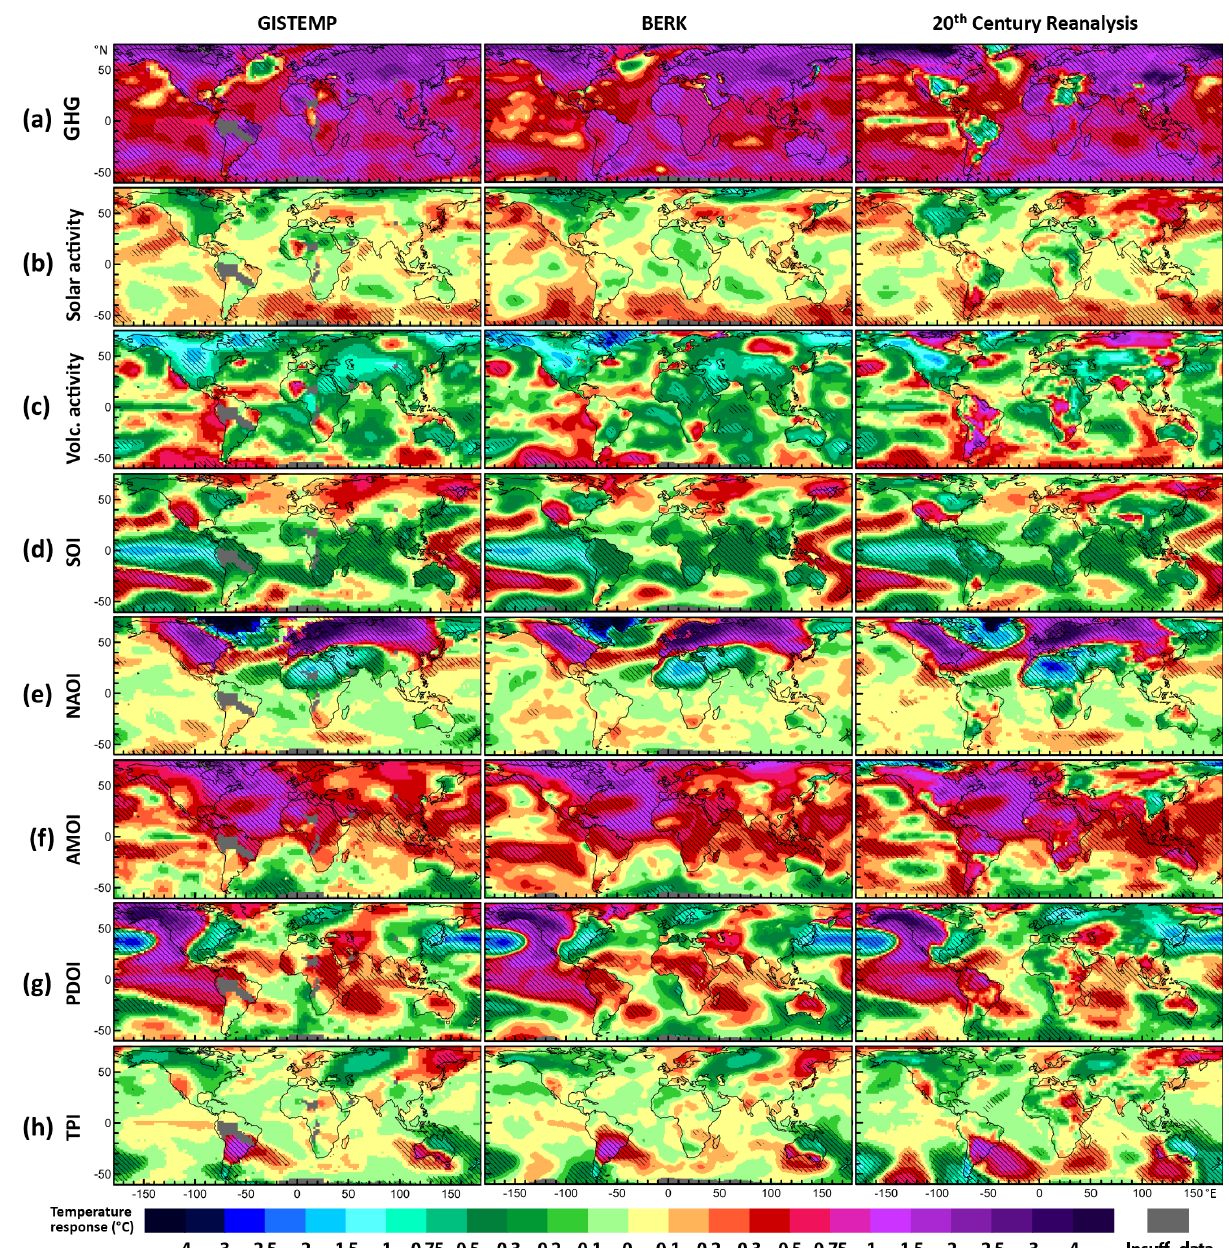
Figure 5. Geographic patterns of regression-estimated contributions to local temperature ( ◦ C) from pre-selected characteristic changes of the explanatory variables (specified in Fig. 1). Time shift of + 1 month (predictor leading temperature) was applied for solar irradiance, + 7 months for volcanic aerosol amount, + 2 months for SOI. Areas with response statistically significant at the 99% level are highlighted by hatching. See Fig. S5 for results derived from the MLOST and HadCRUT4 data sets as well as from GISTEMP data with 250km smoothing; Fig. S6 for results over the 1901–1955 and 1956–2010